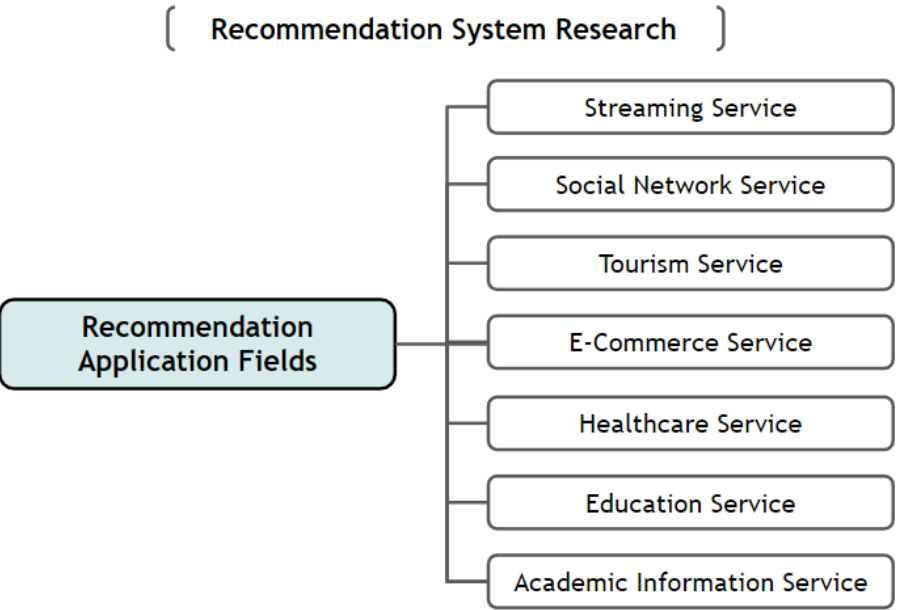
Figure 16. List of services that mainly use the recommendation system analyzed in this study.